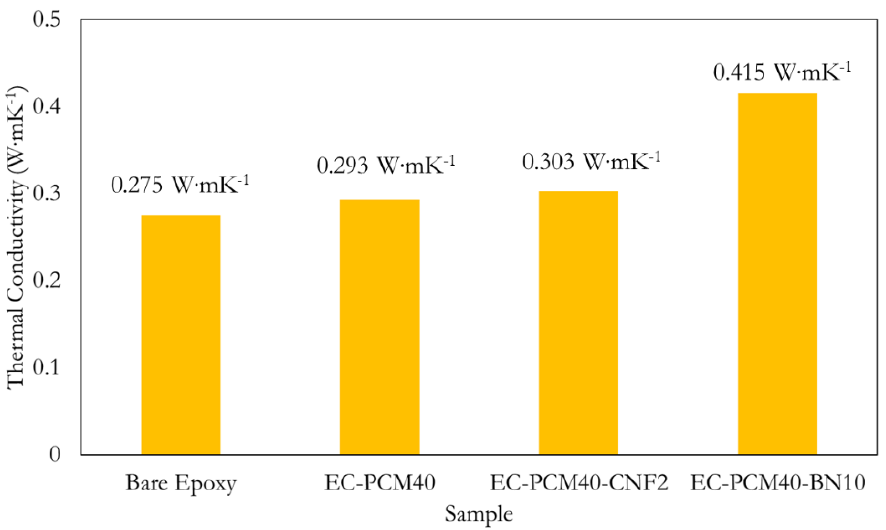
Figure 5. Thermal conductivities of the bare epoxy, EC-PCM40, EC-PCM40-CNF2, and EC-PCM40- BN10 samples . Table 2 . Thermal conductivity comparison with other reports. h-BN: hexagonal boron nitride.